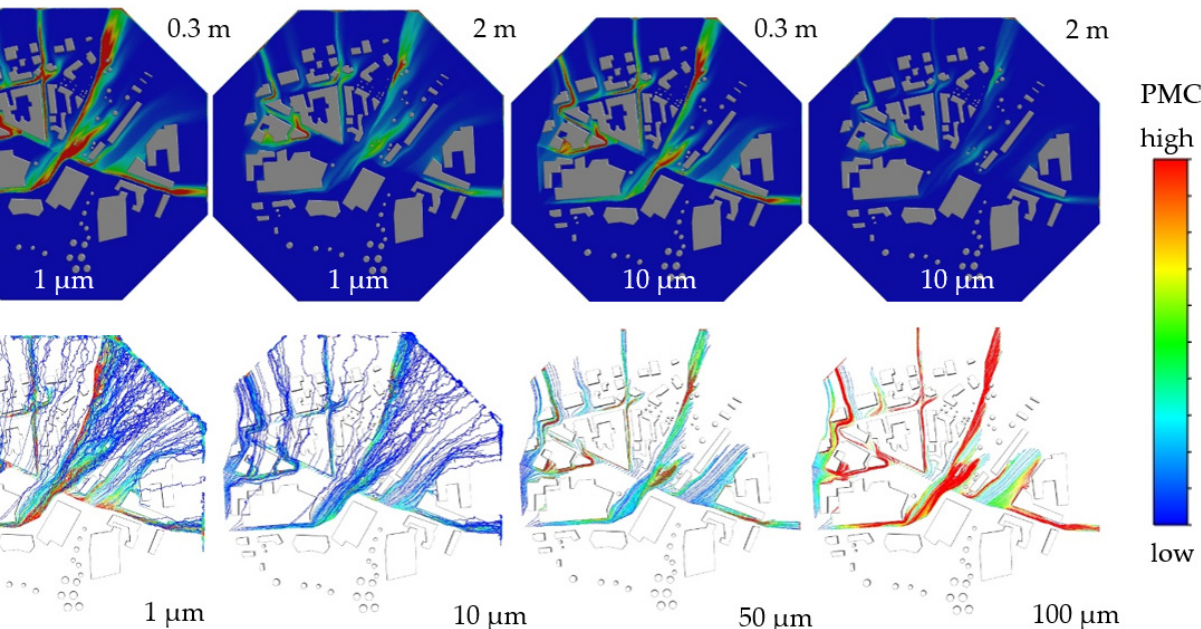
Figure 5. Calculated flow with south–west wind.